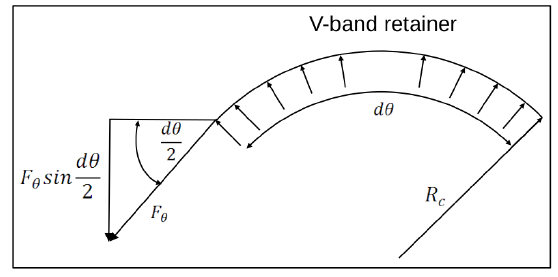
Figure 8: Internal and external forces acting on the V-band